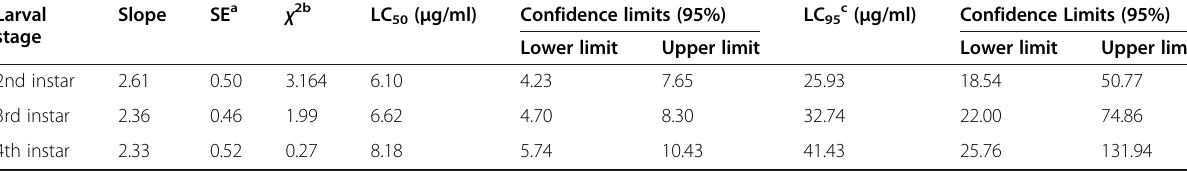
Table 1 Toxicity of 4D1 to 2nd, 3rd and 4th larval instars of tomato pinworm Tuta absoluta Larval Slope SE a χ stage